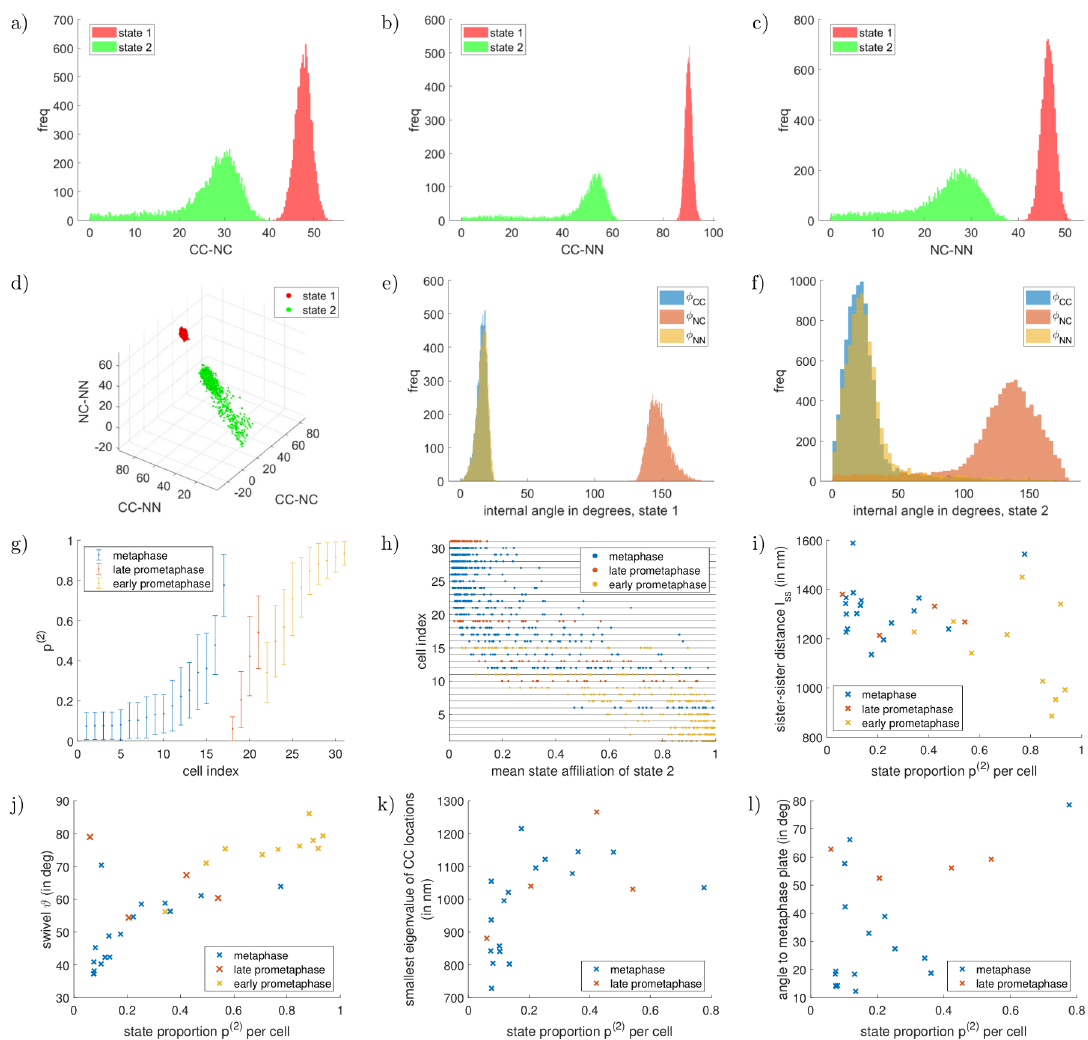
Fig 12. Two-state example for experimental prometaphase-metaphase dataset with cell-based subset analysis, Example C.5. Marginal lengths (in nm) in panels a)–d), the attached state is depicted in red, the natural unattached state in green. See supplement Uninformative priors in S1 Text for the joint prior on the lengths. Marginals of the internal angles of the two states are shown in panels e), f). Panel g) directly shows the means and standard deviations of the inferred state proportions individually for each cell (ordering within the mitotic phase based on mean of p (2) ) and in panel h) each dot denotes the mean state affiliation of a kinetochore in the cell denoted on the vertical axis (ordering based on the mean of p (2) ). Remaining panels compare the inferred state proportion of each cell with tension parameters—each datapoint shows averages of one cell: Shown are the i) sister-sister distance l ss , j) swivel ϑ ; k) metaphase plate width (smallest eigenvalue of the CenpC locations); l) angle of the sister-sister axis to the normal of the metaphase plate (eigenvector of the smallest eigenvalue of the CenpC locations), each plotted against the state proportion of the natural unattached state. Mitotic phase is colour-coded. Error bars are suppressed for visibility. Kinetochore-based correlation statistics are shown in Table K in S1